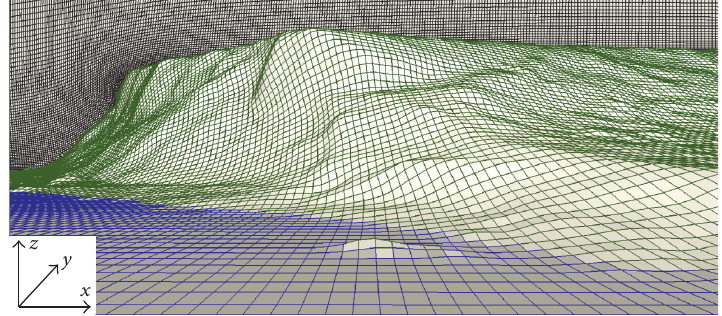
Figure 3: Numerical model of Bolund Hill with a surface